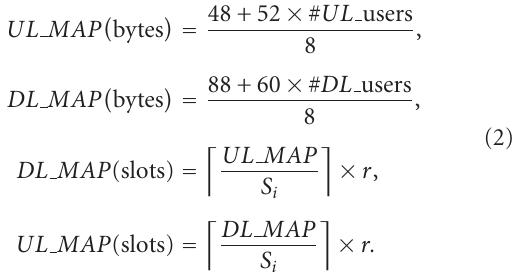
Figure 4: UL burst preamble and MAC PDU